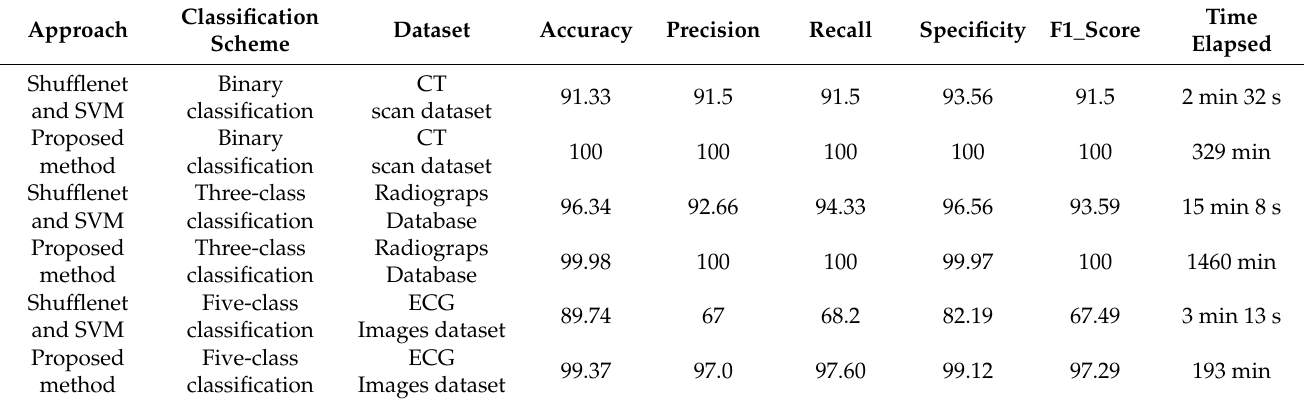
Table 12. Hybrid approach